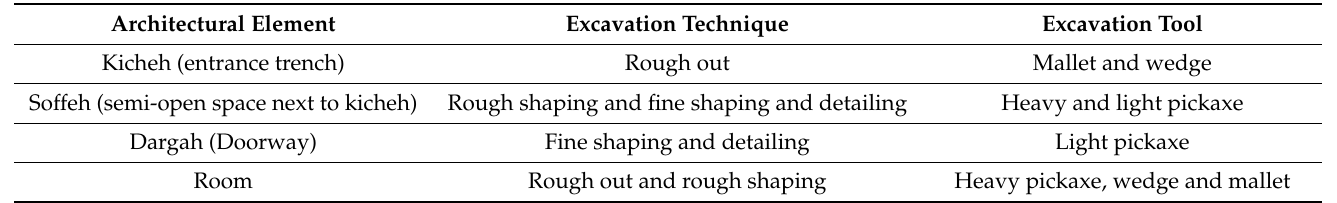
Table 2. The relationship between architectural elements and excavation tools used in